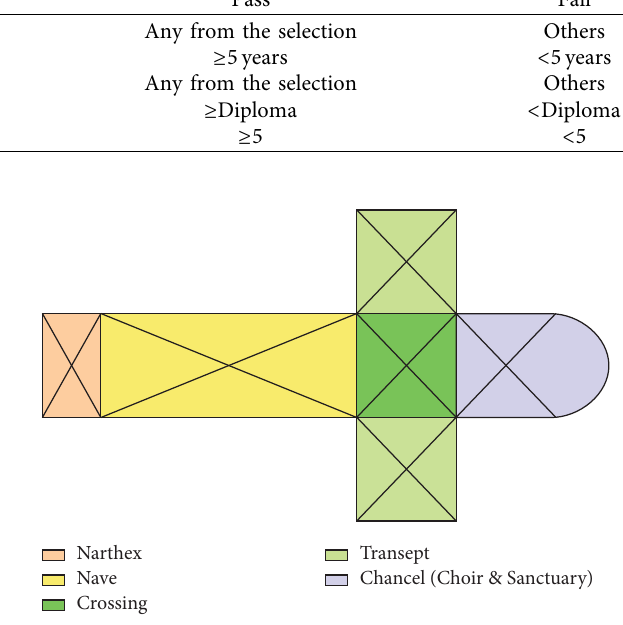
Figure 3: Schematic plan of an Anglican church in